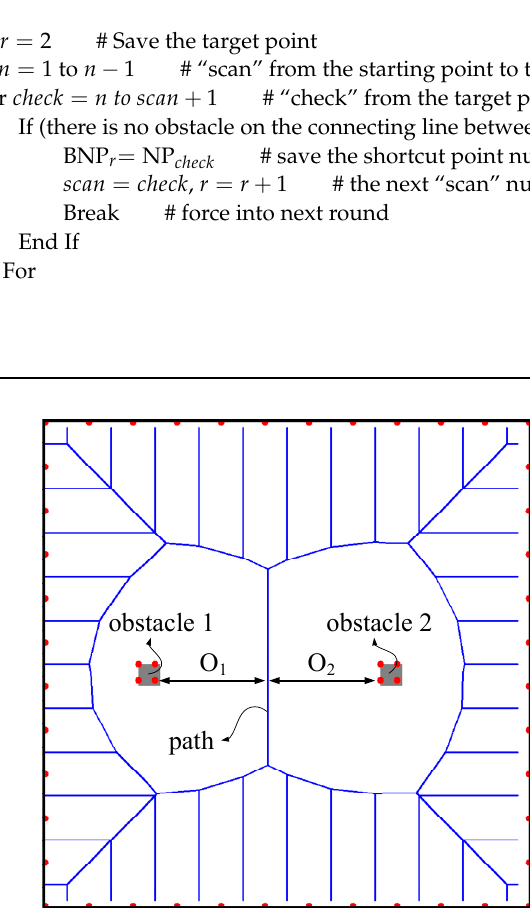
Figure 5. All feasible paths generated by the GVD.